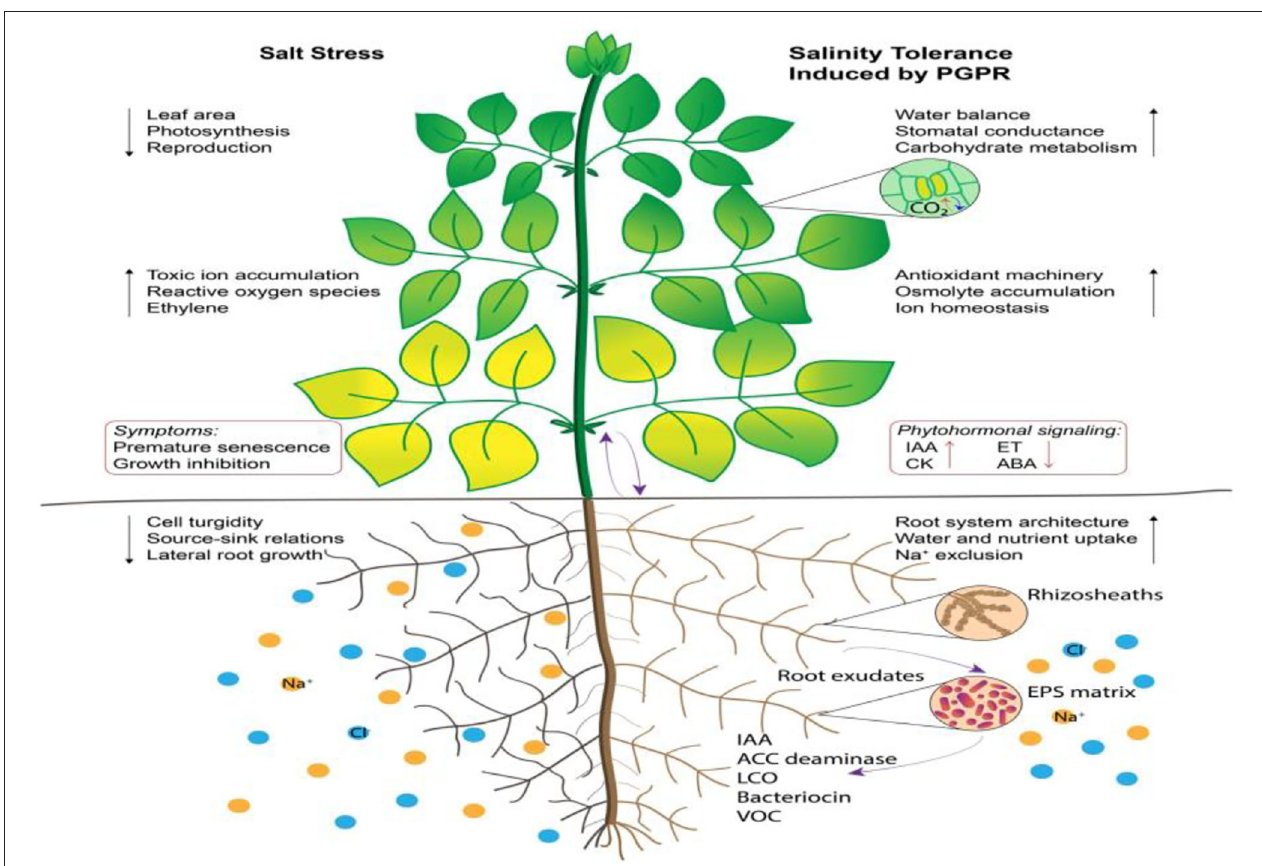
FIGURE 3 | Effect of PGPR on salt tolerant strategy of plants. Source: adapted from Ilangumaran and Smith